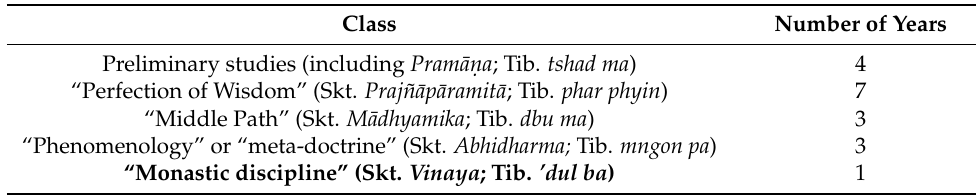
Table 1. The Gelukpa monastic curriculum in Dolma Ling. Class Number of Years Preliminary studies (including Pram¯an. a ; Tib. tshad ma ) 4 “Perfection of Wisdom” (Skt. Prajñ¯ap¯aramit¯a ; Tib. phar phyin ) 7 “Middle Path” (Skt. M¯adhyamika ; Tib. dbu ma ) 3 “Phenomenology” or “meta-doctrine” (Skt. Abhidharma; Tib. mngon pa ) 3 “Monastic discipline” (Skt. Vinaya ; Tib. ’dul ba )